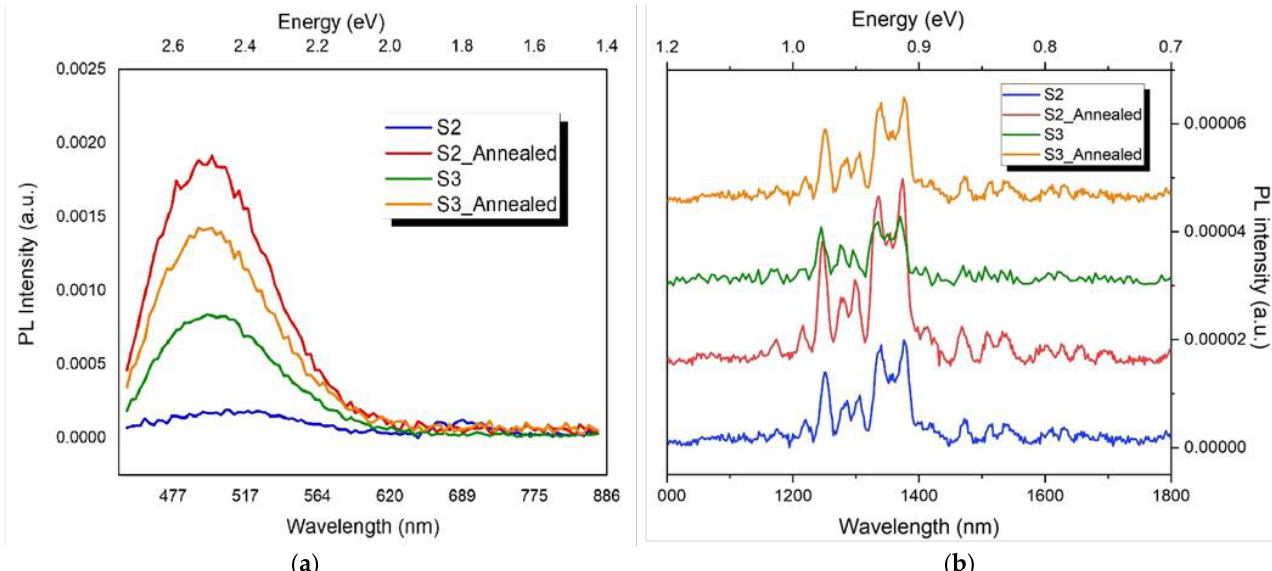
Figure 4. PL spectra for as deposited and annealed SnS films recorded at 20 K for ( a ) visible and ( b ) infrared range.